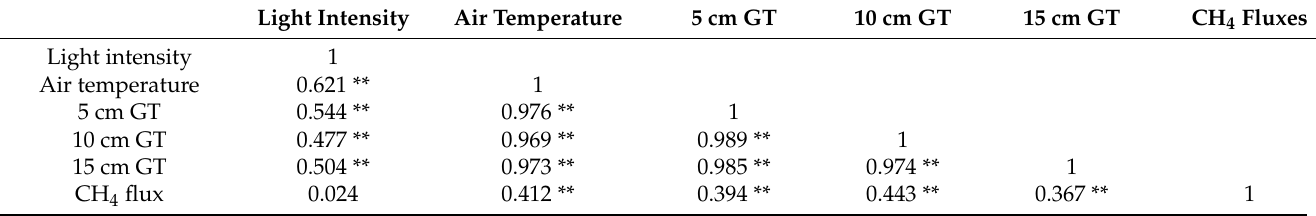
Table 1. Correlation relationship between the CH 4 fluxes and environmental